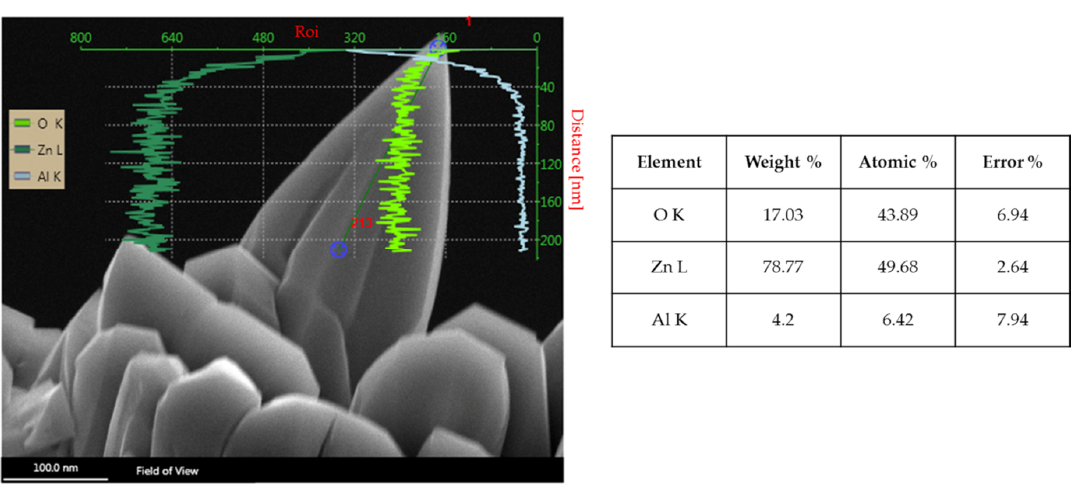
Figure 9. XRD spectra of ZnO nanowhiskers grown in optimized conditions at different runs ( a ), ( b ) on silicon wafers ( c ). Reflections at 2  ≈ 38° and 64° arise from the equipment sample holder of aluminum. Inset spectra were obtained via GI-XRD (1° incident angle).